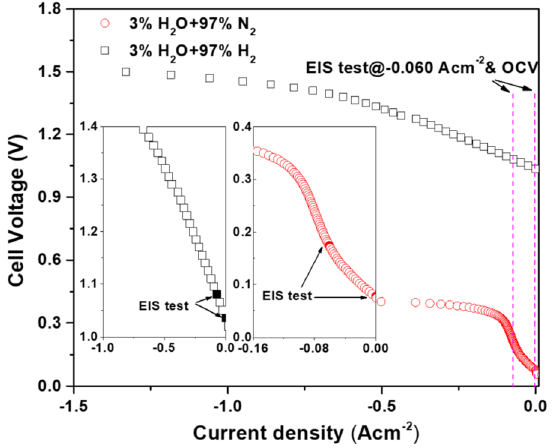
Fig. 1 i-V curves measured at 800 °C for the symmetrical SFM-SDC/ LSGM/SFM-SDC electrolysis cell operating its cathode in 3%H 2 O humidified N 2 (red circle) and H 2 (black square), respectively